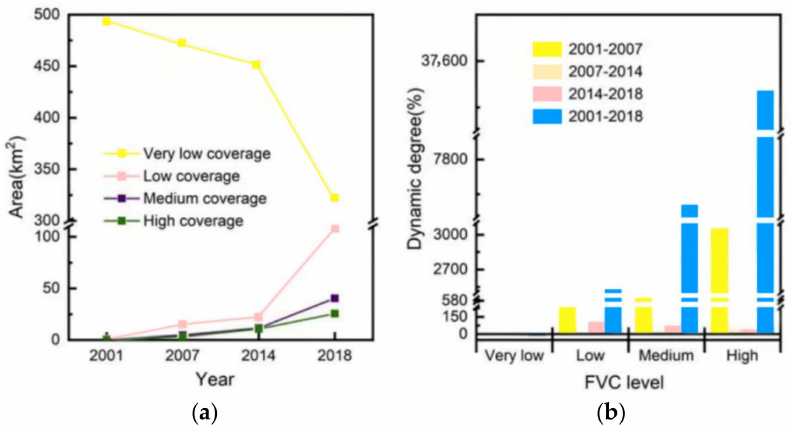
Figure 4. Area changes of different fractional vegetation cover types in Taitema lake region ( a ) and dynamic degree ( b